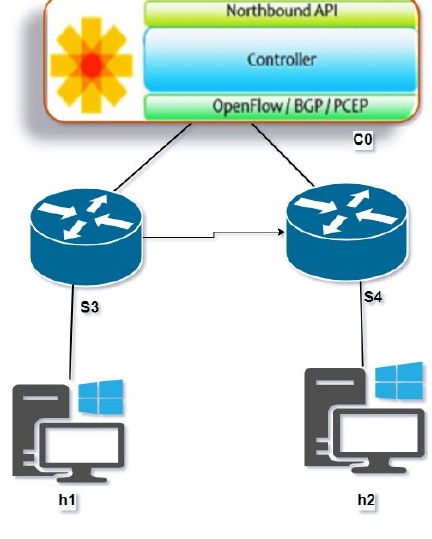
Figure 19. Basic command for custom topology on Mininet.